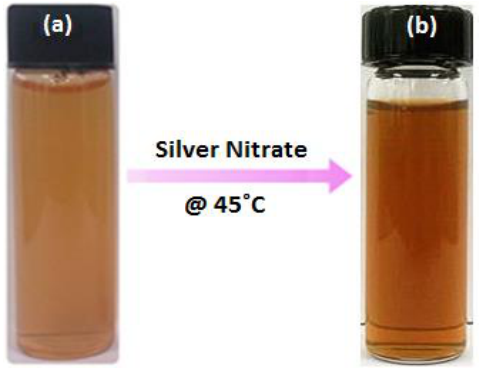
Figure 1. Change of colour after the addition of AgNO 3 . ( a ) crude GM peels extract and ( b ) crude GM peels extract with addition of AgNPs solution.